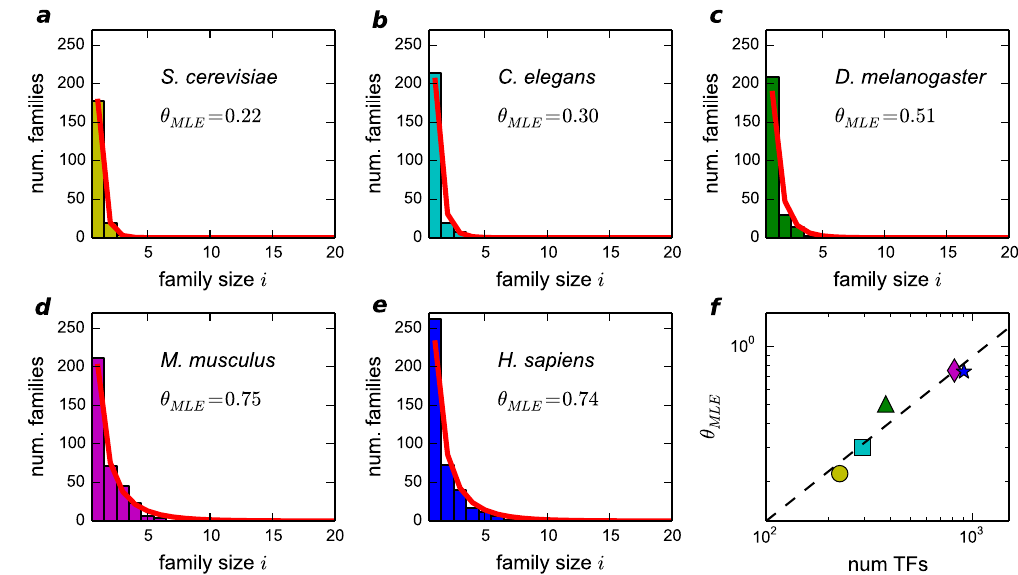
Figure 5. Size distribution of TF motif families for different eukaryotic organisms. ( a – e ) We report the distributions and the best fit values of θ for five different organisms of increasing complexity. As for the human case, the data are taken from the CIS-BP database. ( f ) The bottom-right panel shows how θ scales with the number of TFs. The red-line is the fit θ ~ (# TFs) 0.85